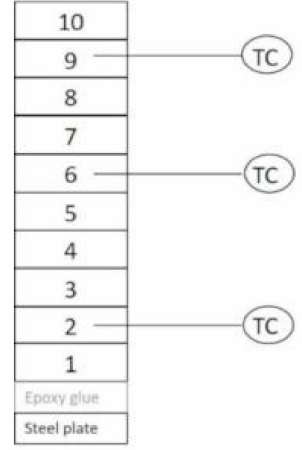
Figure 4. Illustration of thermal gradient measurement in